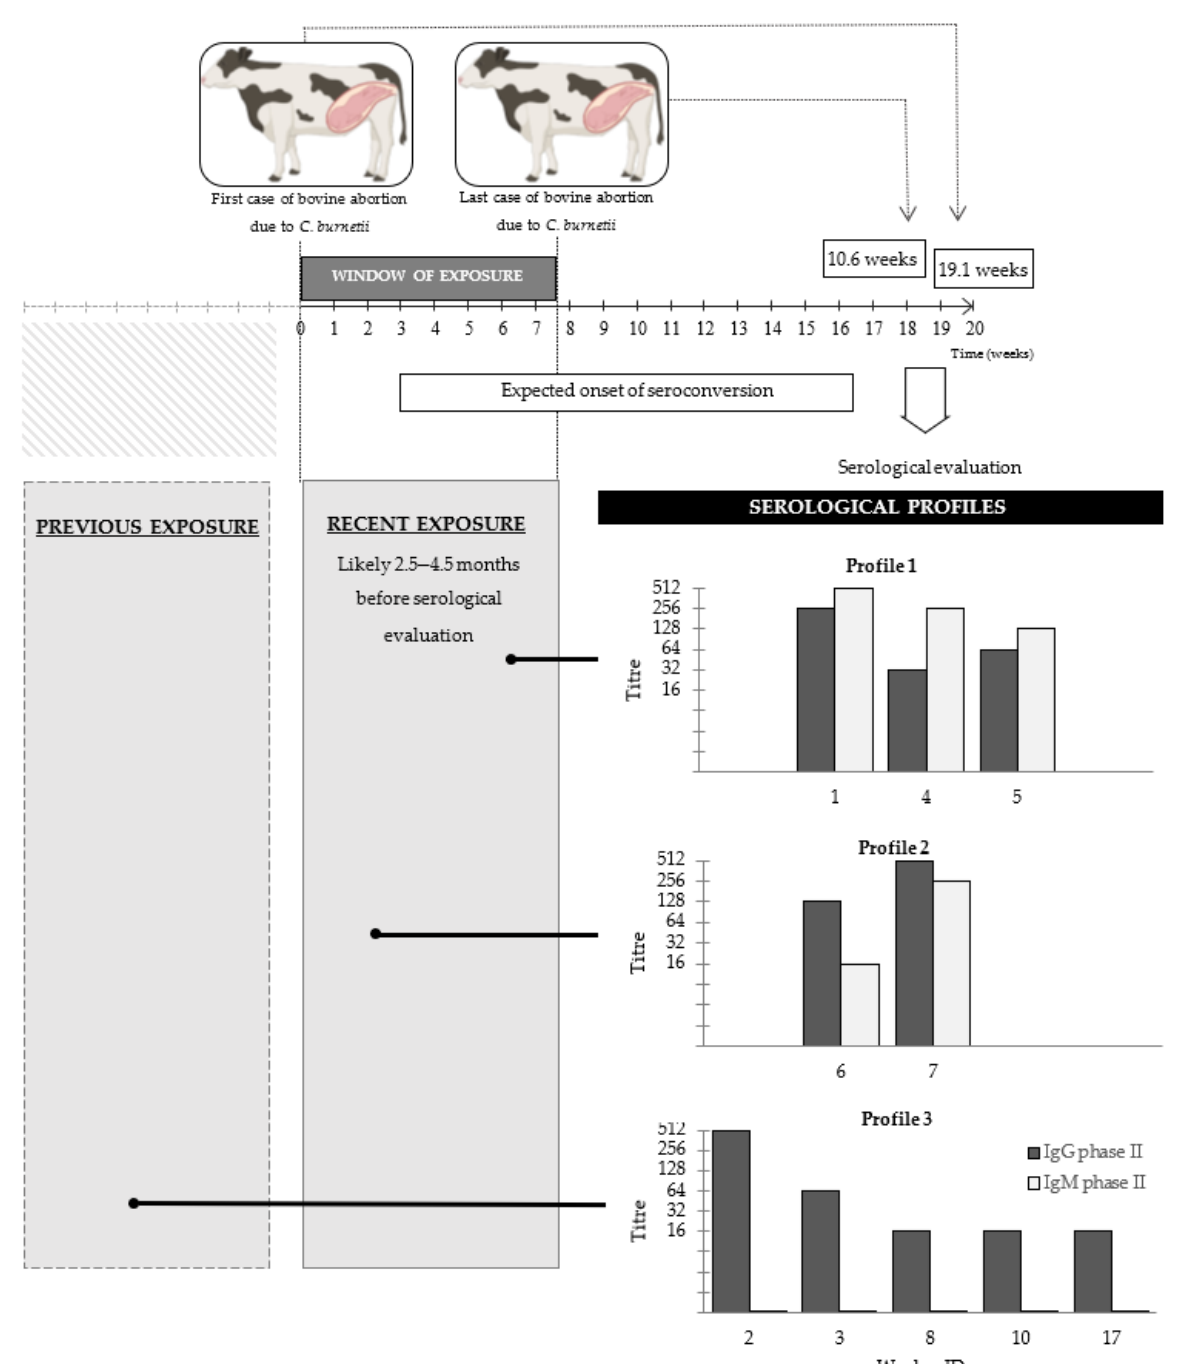
Figure 1. Timeline of the Q fever outbreak in cattle and serological investigations in farm and laboratory workers. Time zero was the date of the first case of bovine abortion. The window of exposure of farm and laboratory workers (when abortions occurred, and aborted materials were collected and submitted to the local veterinary diagnostic laboratory for diagnostic work-up) lasted for 7.7 weeks (10 April to 2 June 2017). The time course of the seroresponse was estimated based on published observations (Todkill et al., 2018). Serological sampling of humans was conducted on 14 and 21 August 2017, i.e., 18.1 and 19.1 weeks following the opening of the exposure window. Serological profiles are based on anti- C. burnetii phase II IgG and IgM levels measured by indirect fluorescent antibody test (IFAT). The profile of immunoglobulins was used to ascertain how recently they were likely to have been infected: Profile 1: both isotypes detected, IgM titre > IgG titre—very recent; Profile 2: both isotypes detected, IgM titre < IgG titre; Profile 3: IgG detected but not IgM. Profile 4: neither IgM nor IgG detected (data not shown). Reciprocal titres are shown.